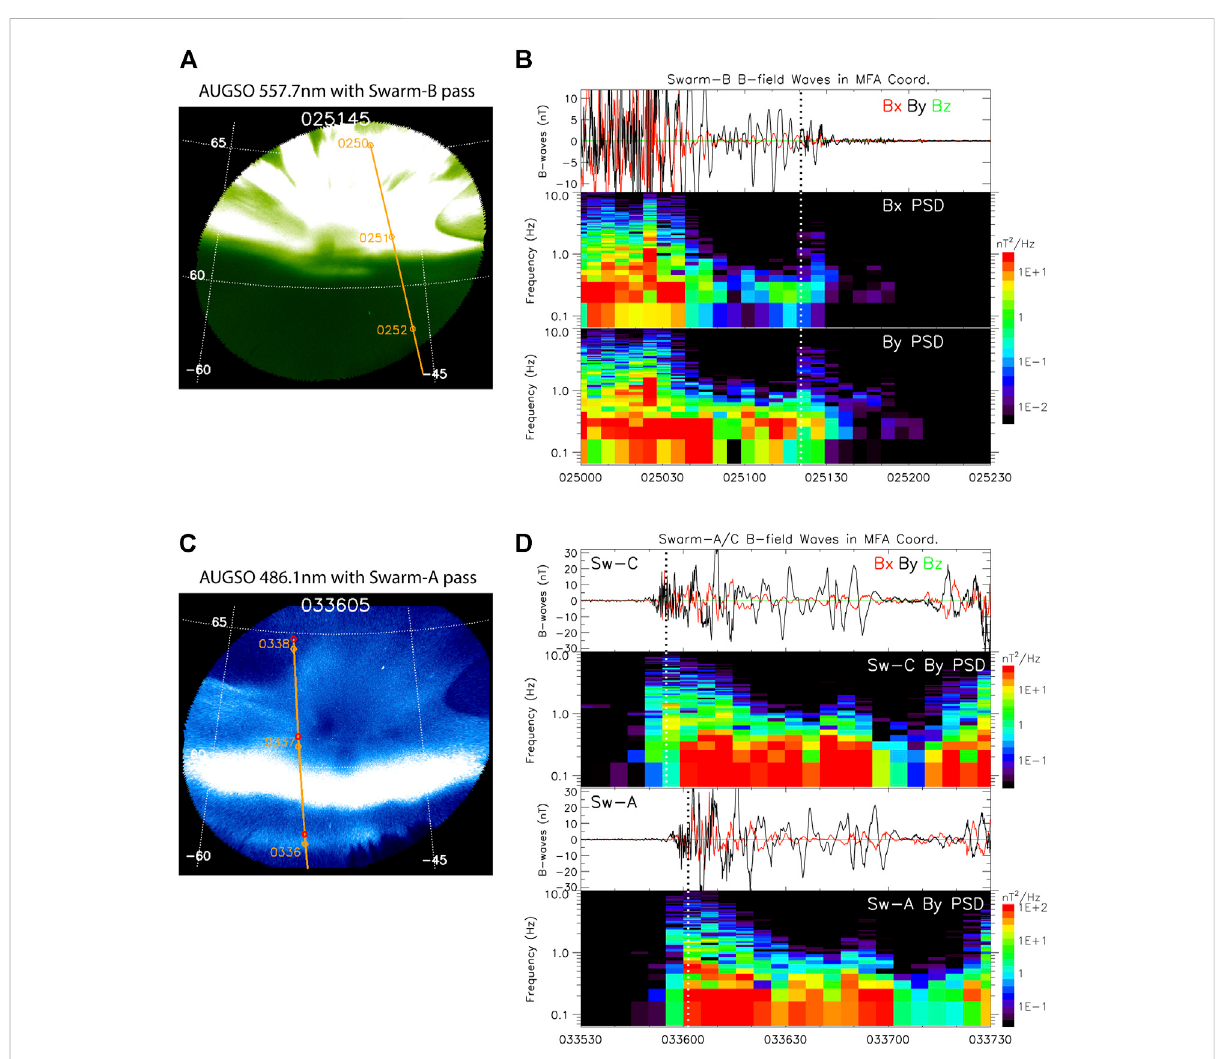
FIGURE 5 (A) AUGSO 557.7 nm images with Swarm-B footprint trajectory overplotted. Emission altitude is 115 km. (B) The top panel shows the high- passed magnetic fi eld waves in MFA coordinate. The rest two panels show the PSD spectrogram of the Bx and By wave components. (C) AUGSO 486.1 nmimageswithSwarm-A(orange)andSwarm-C(red)footprinttrajectory.Emissionaltitudeis135 km. (D) ThetoptwopanelsshowtheB- fi eld waves and By PSD spectrogram on Swarm-C. The bottom two panels show the B- fi eld waves and By PSD spectrogram on Swarm-A. In each panel, a vertical dotted line indicates the estimated center time of IPA